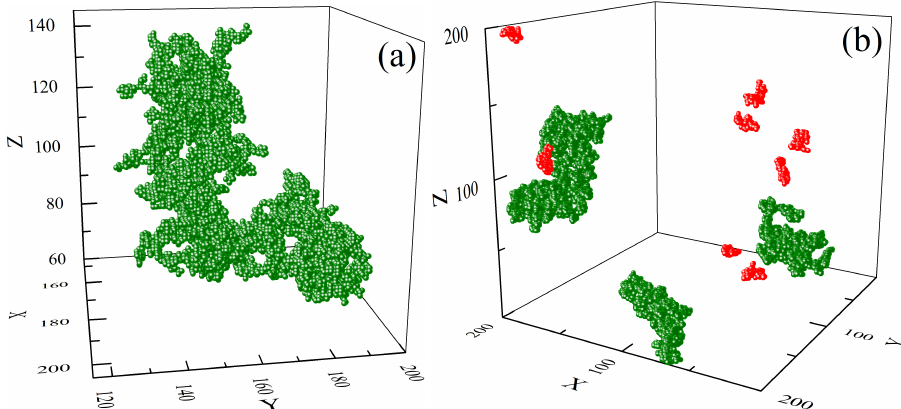
Figure 8. ( a ) Snapshot of a cluster of cells with V = 6 (7614 cells). ( b ) Snapshots of clusters of cells with V = 5 (red dots, approximately 100 cells) and of clusters with V = 6 (green dots, size (3–7) × 10 3 cells) in the simulation box. T = 0.25. Based on